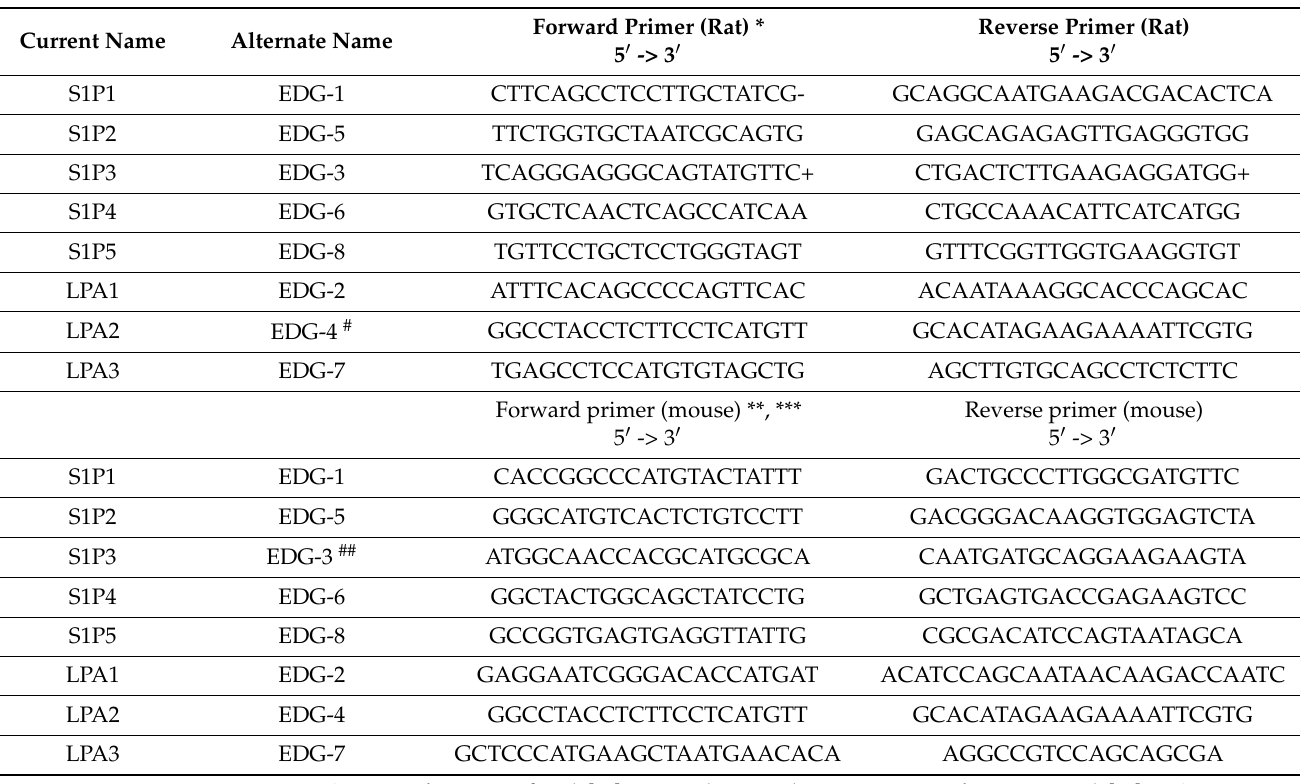
Table 2. Primer sequences for RT-PCR analysis of rat and mouse S1P and LPA receptors in rat and mouse olfactory mucosa and rat-derived Odora